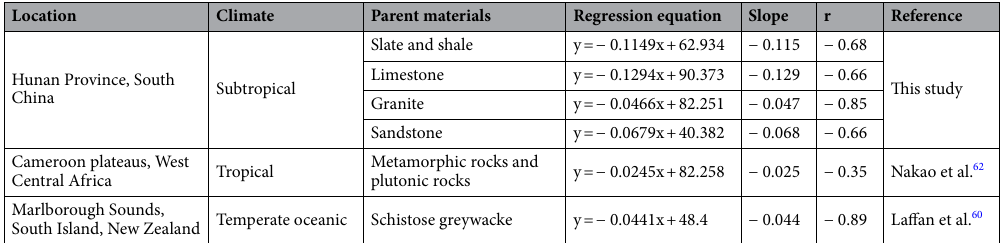
Table 4. Results of the literature survey of correlation between clay mineral (kaolinite) and altitude in different climate